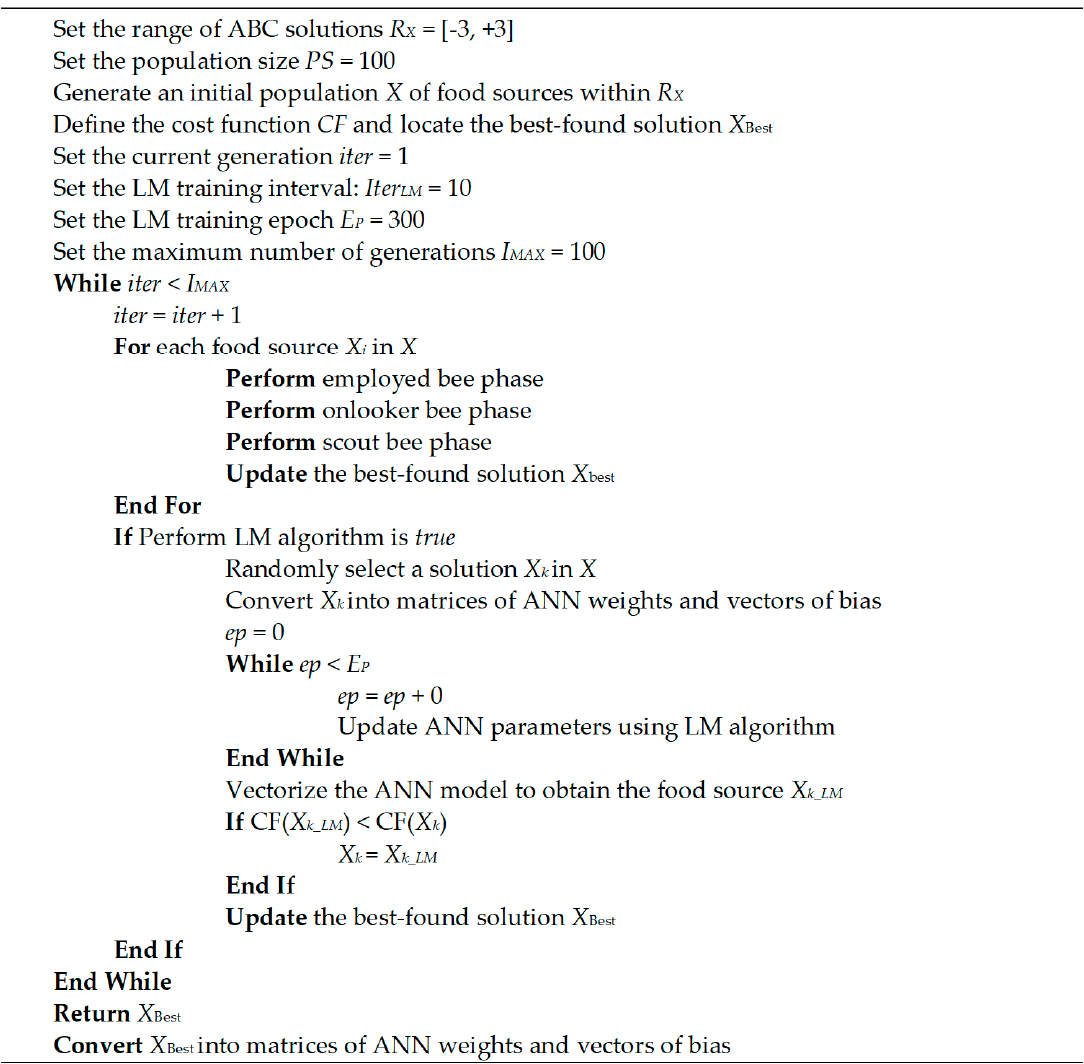
Figure 6. The training flow of the ABC-LM algorithm.